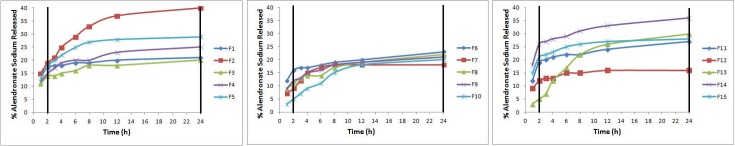
In-vitro release of alendronate sodium from different formulations.